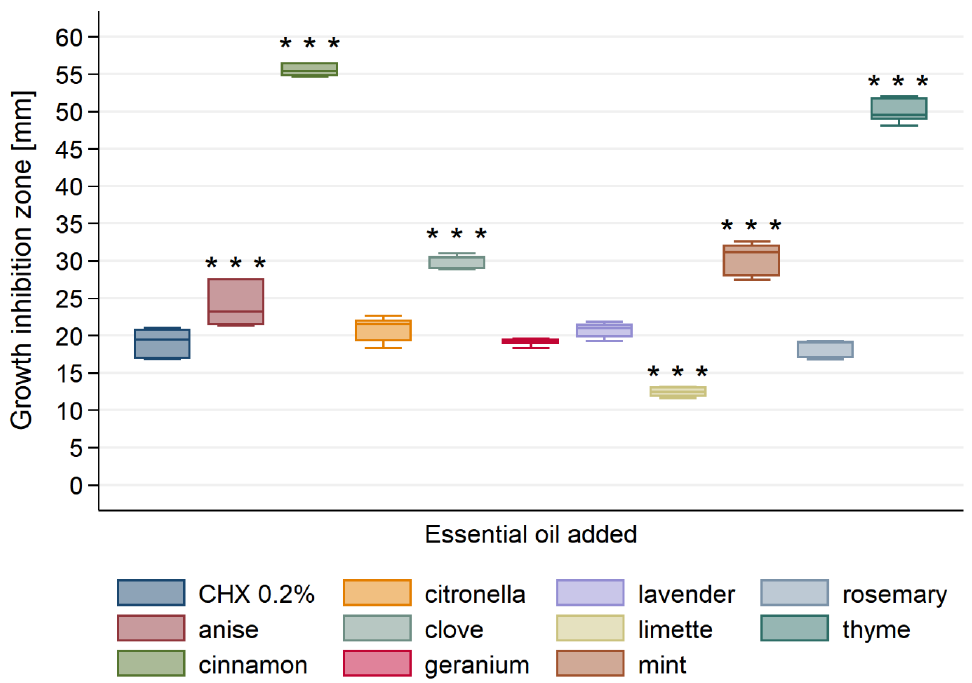
Figure 4. Antifungal activity of tested essential oils against C. albicans . *** p < 0.001 versus positive control (0.2% CHX).